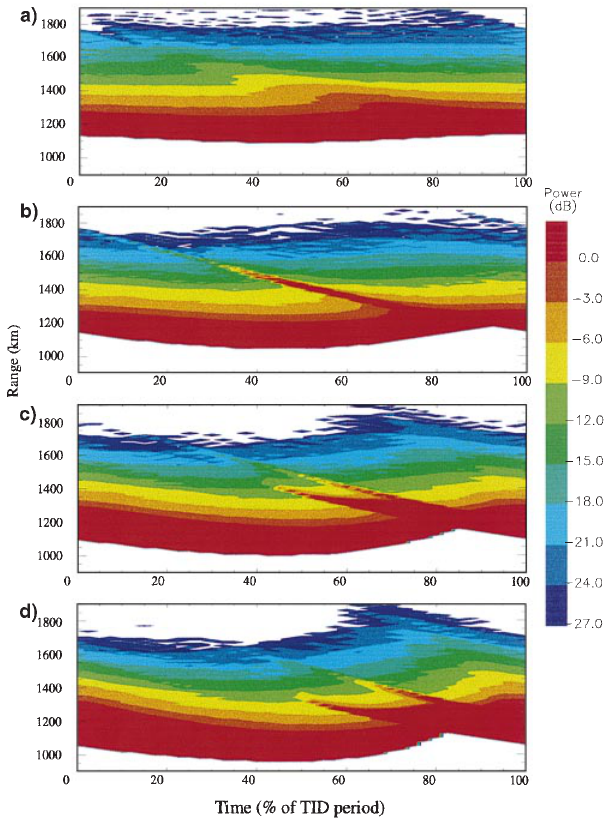
Fig. 4a–d. Range-time-intensity plots derived from ray tracing for the CUTLASS radar operating at 9.97 MHz on 26 January 1997. TID electron density perturbation amplitude is a 5%, b 15%, c 25% and